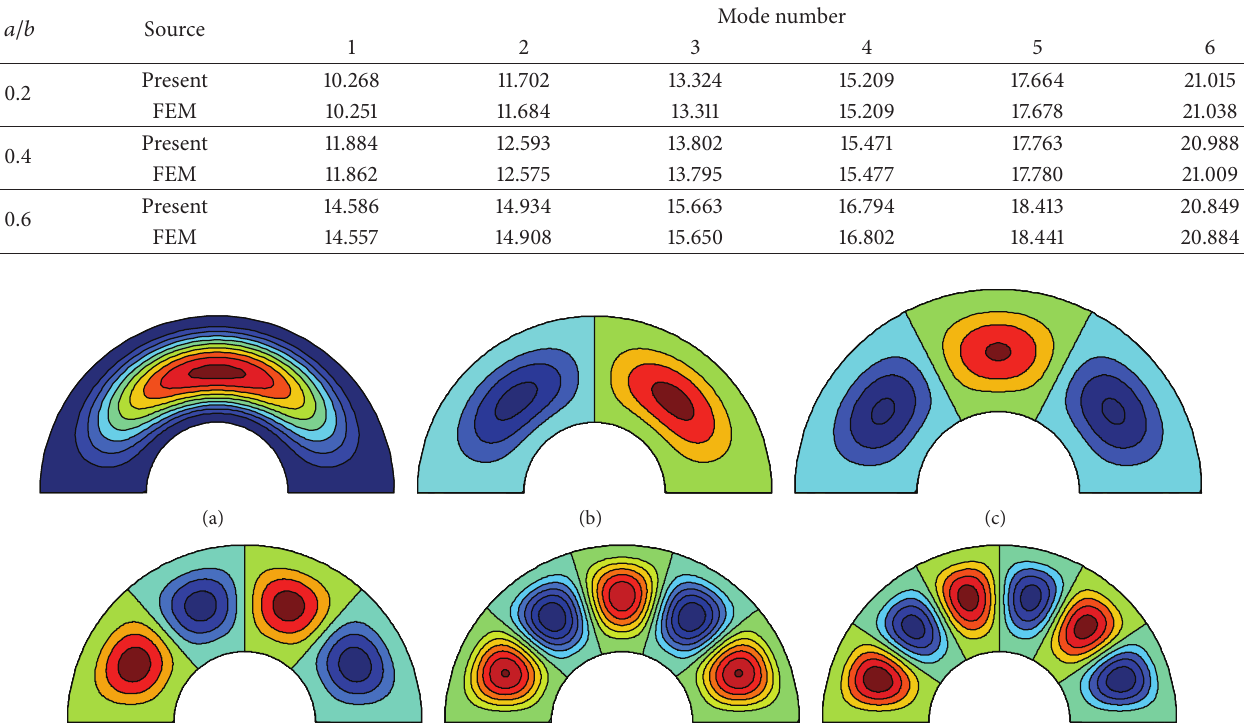
Table 8: Frequency parameters, Ω = 𝜔𝑏 2 (𝜌ℎ/𝐷) 1/2 , for annular sector plates with elastic restraint at all four edges: 𝑘 = 10 5 N/m and 𝐾 = 10 7 Nm/rad ( 𝜙 = 16𝜋/9 and 𝜇 = 0.3 ).